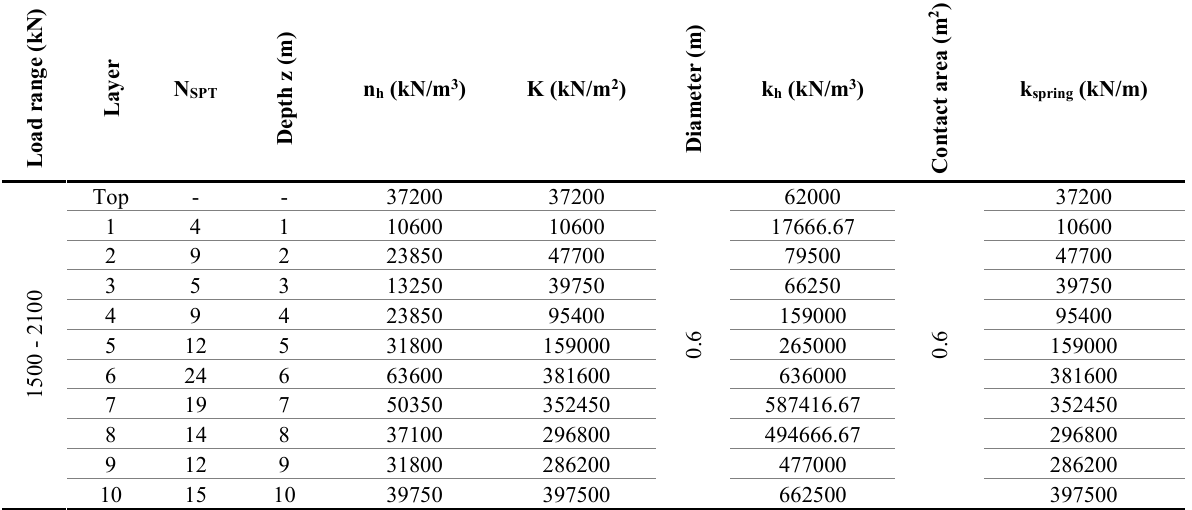
Table 4. Coefficients of horizontal reaction of the